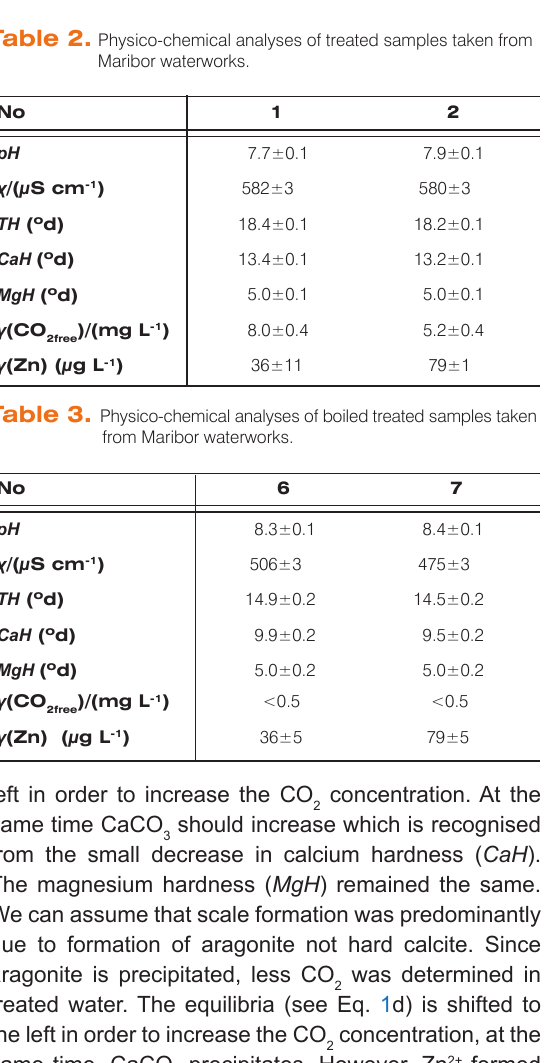
Table 3 presents the analyses of the boiled water Table 2. Physico-chemical analyses of treated samples taken from